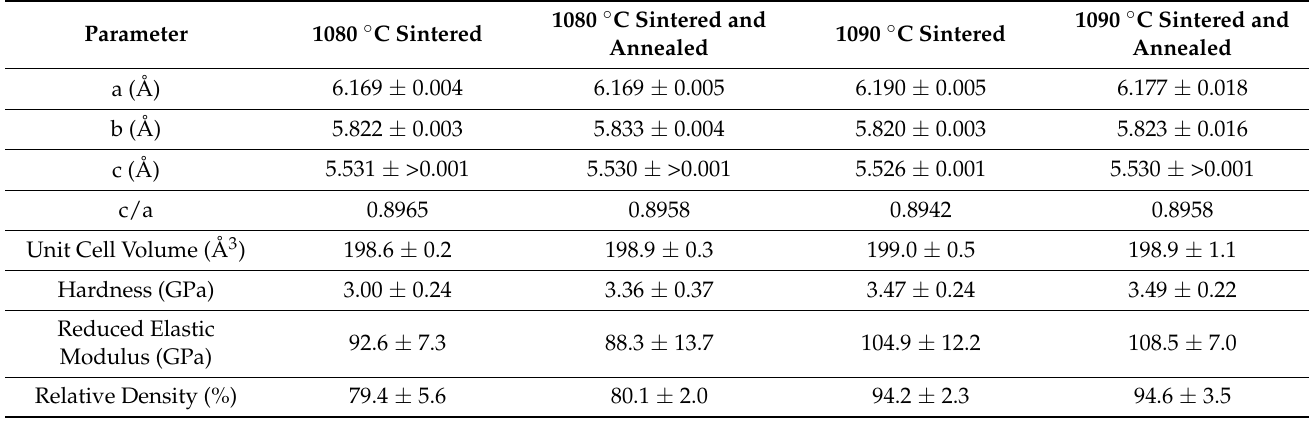
Table 1. Crystallographic, mechanical, physical, and phase transformation properties of the Ni–Mn– Ga binder jetted samples.